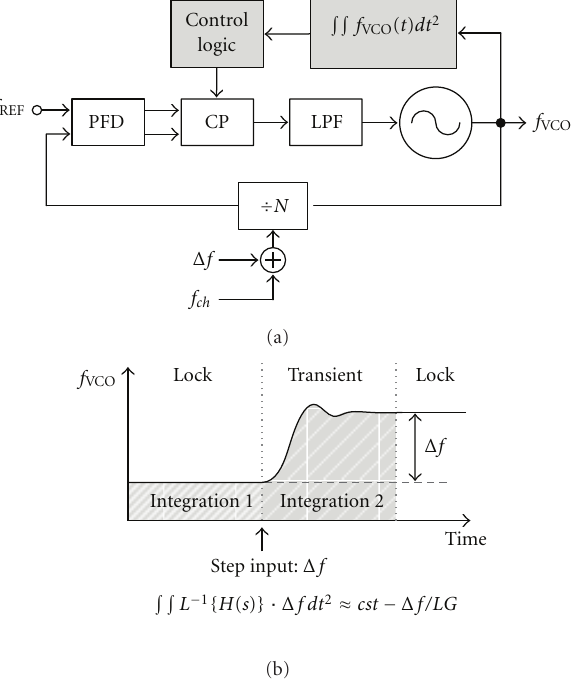
Figure 9: Loop gain calibration by measuring step-response of PLL (a) Architecture. (b) Operation principle [10, 11].